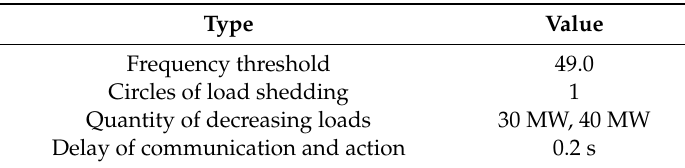
Table 3. Settings of traditional UFLS approach.